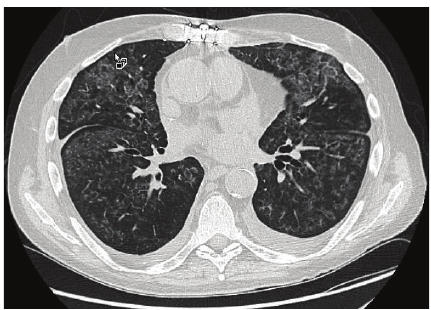
Figure 2: High-resolution axial computed tomography scan of the chest shows diffuse ground-glass abnormalities with interlobular septal thickening in the characteristic “crazy paving” pattern after initiation of everolimus